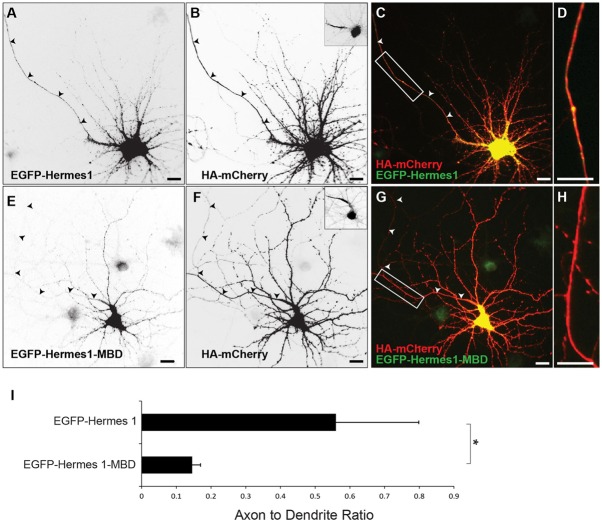
Association with Myosin Va is sufficient for somatodendritic targeting of a non-specifically localized mRNA binding protein, Hermes 1.A. EGFP-Hermes1 localizes both to the axon and dendrites of neurons co-expressing HA-mCherry (B). Insets show Ankyrin G staining, which labels the axon initial segment of the corresponding cell. C. Merge of HA-mCherry (red) and EGFP-Hermes1 (green). D. High power image of boxed area in (C). E. EGFP-Hermes1 fused to a Myosin Va binding domain (EGFP-Hermes1-MBD) localizes specifically to the somatodendritic compartment of a cortical neuron co-expressing HA-mCherry (F). G. Merge of HA-mCherry (red) and EGFP-Hermes1-MBD (green). H. High power image of boxed area in (G). I. The axon to dendrite ratio of Hermes 1 is significantly higher than that of Hermes 1-MBD. * indicates p<0.02 (Wilcoxon). Scale bar is 10 μm.